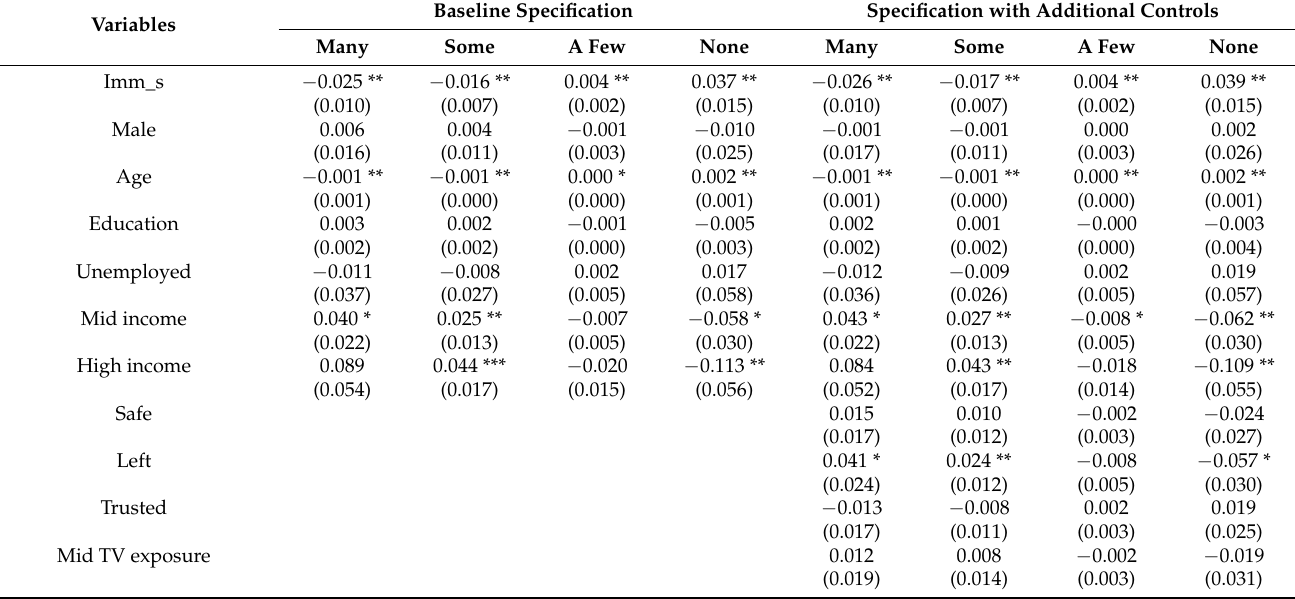
Table 3. Should Turkey allow people of the same race or ethnic group as most Turkish people to come and live here?